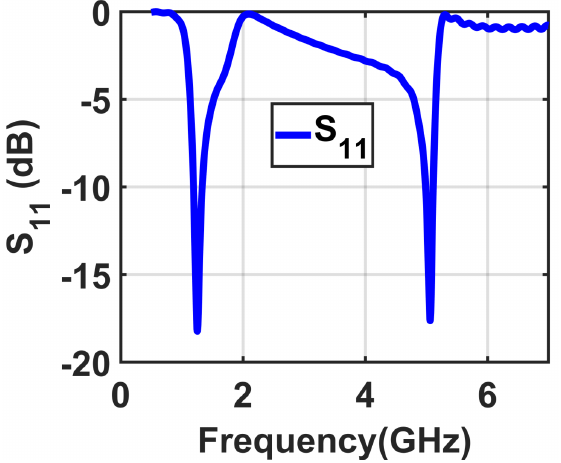
Figure 1. The presented unit cell: ( a ) top loop layer, ( b ) bottom loop layer, ( c ) top and bottom loop layers connected with two connectors, and ( d ) view of the top and bottom layers with the ground spacer reflector.